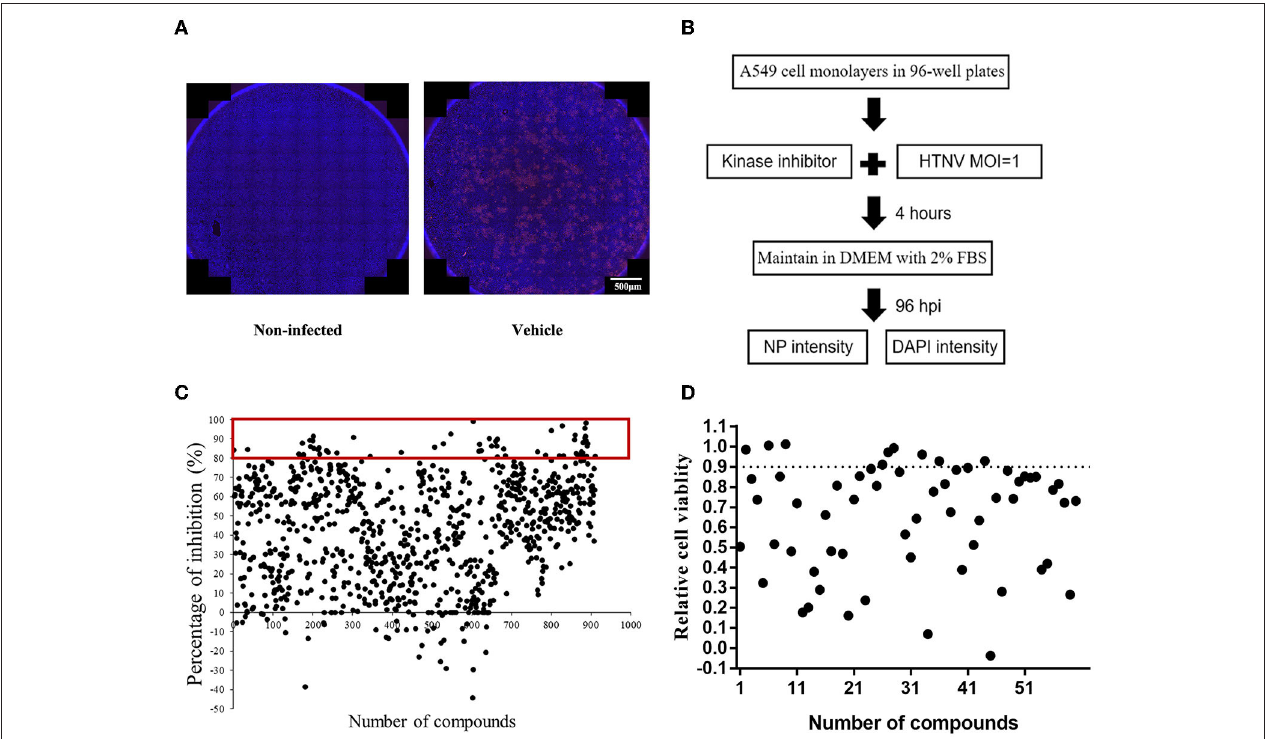
FIGURE 1 | The screening of protein kinase inhibitors with anti-Hantaan virus (anti-HTNV) activity. (A) Observation of the anti-HTNV activity of kinase inhibitors by immunofluorescence assay (IFA), red staining for the expression of nucleocapsid protein (NP), and blue staining for the cell nuclei, scale bar = 500 µ m. (B) Preliminary high-throughput screening of protein kinase inhibitors with anti-HTNV activity. (C) Among 901 protein kinase inhibitors, 60 could inhibit the HTNV more than 80%. (D) Among the above 60 protein kinase inhibitors, 10 compounds had no significant effect on cell